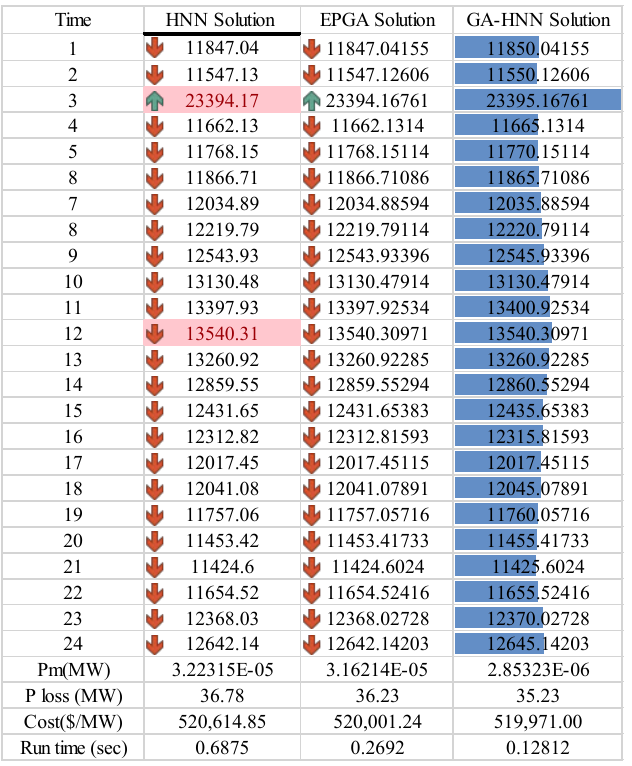
intermittent renewables concurrently increases their security level and decreases total generation cost. It is also worth noticing solving OGD using GA-HN provides optimal allocation of generation level, contingency reserve and penalty reserves that help power system operation regain normal operation after blackout